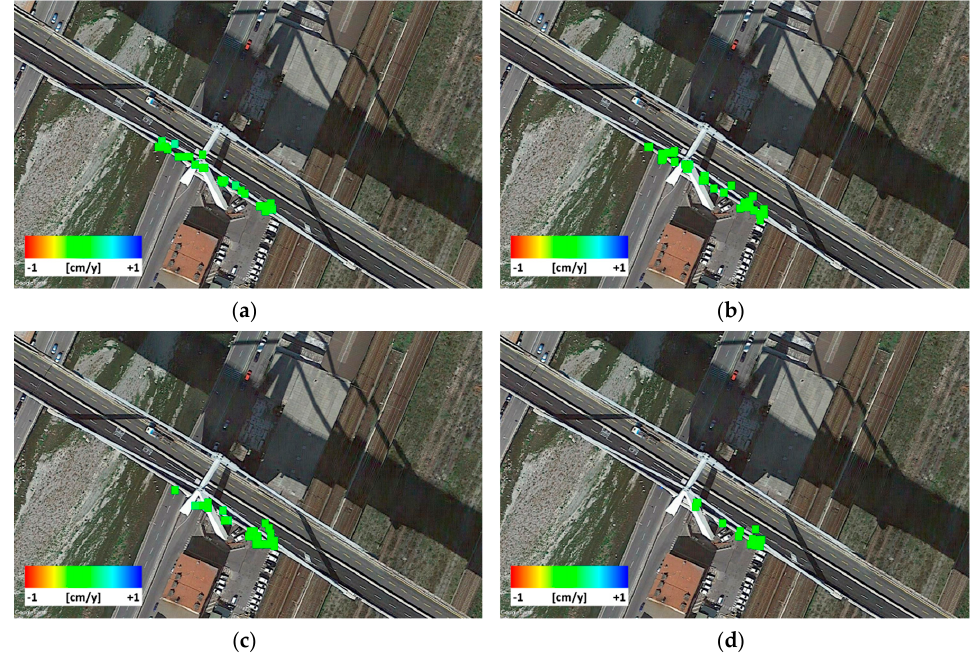
Figure 12. Zoom of Figure 9 in the area of interest related to the collapsed pillar, ( a ) SBAS and ( b ) TomoSAR processing results over the ascending dataset, and ( c ) SBAS and ( d ) TomoSAR processing results related to the Descending dataset.